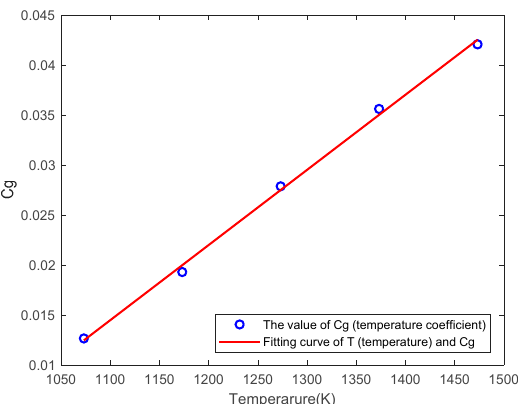
Figure 4. Fitting curve of the temperature measurement coe ffi cients and the temperatures.